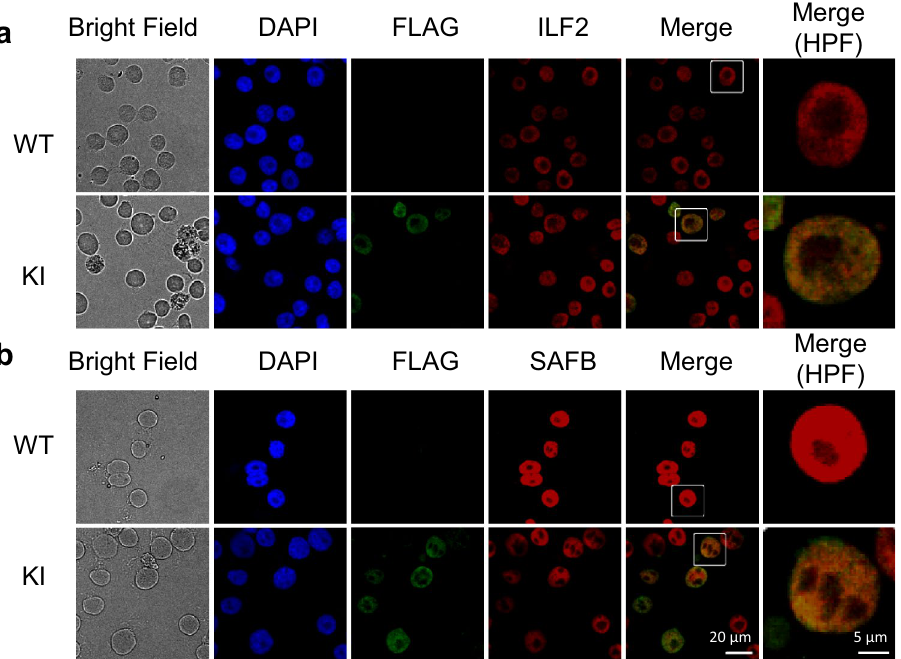
Figure 4. A3B co localizes with ILF2 and SAFB in the nucleus. AMO1 KI cells were subjected to immunofluorescence using Alexa Fluor 555 labelled anti mouse secondary antibody. Endogenous ILF2 ( a ) and SAFB ( b ) were visualized using Alexa Fluor 647 labelled anti rabbit secondary antibody and DAPI was used to stain the nucleus. Image acquisition was performed with a confocal laser scanning microscope (BZ